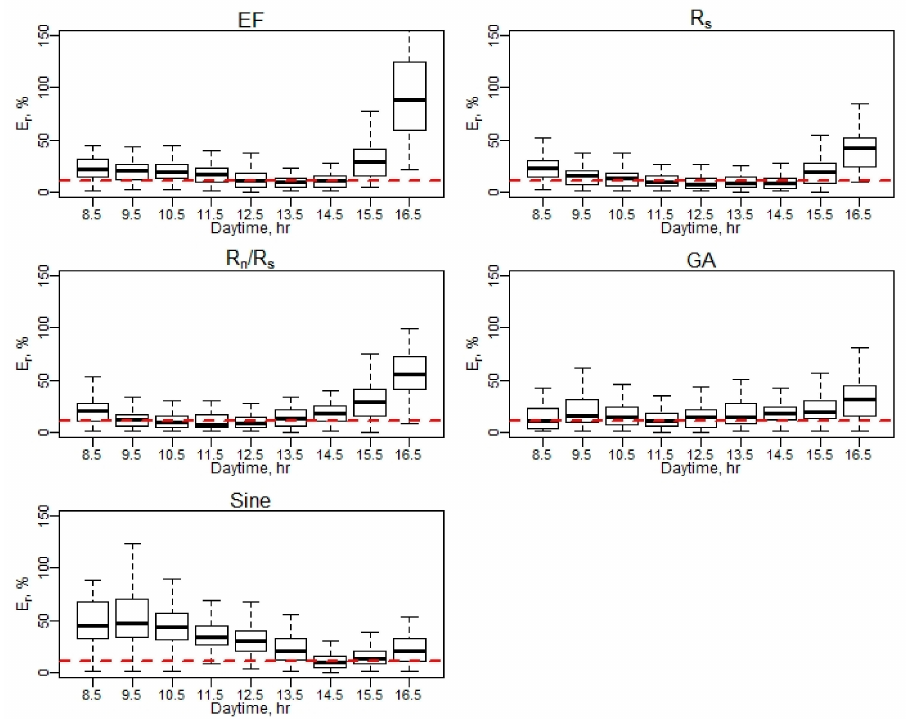
Figure A24. E r of daily EC ET (September–October). Note: Red dash line represents a 10% relative error ( E r